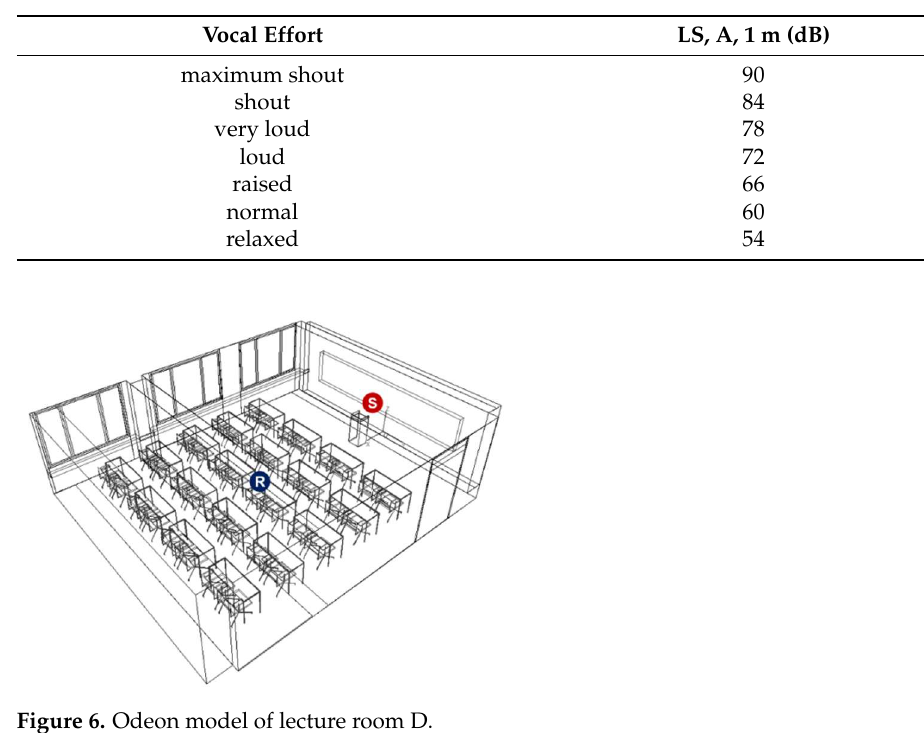
Figure 6. Odeon model of lecture room D.